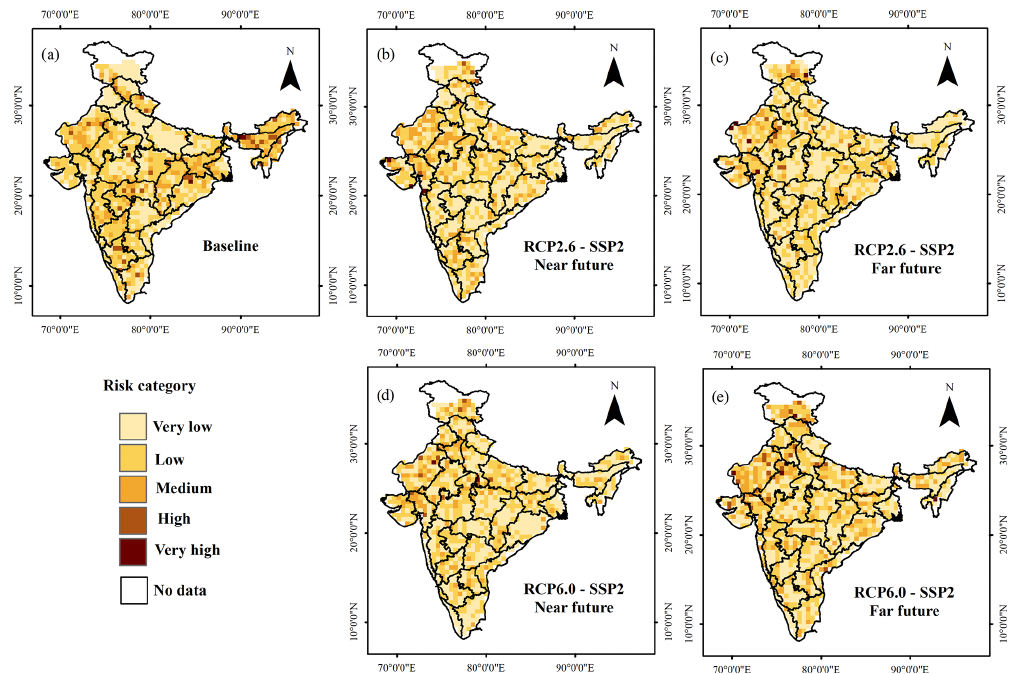
Figure 7. Multi-model ensemble drought risk maps for the scenarios (a) baseline, (b) RCP2.6-SSP2-Near future, (c) RCP2.6-SSP2-Far